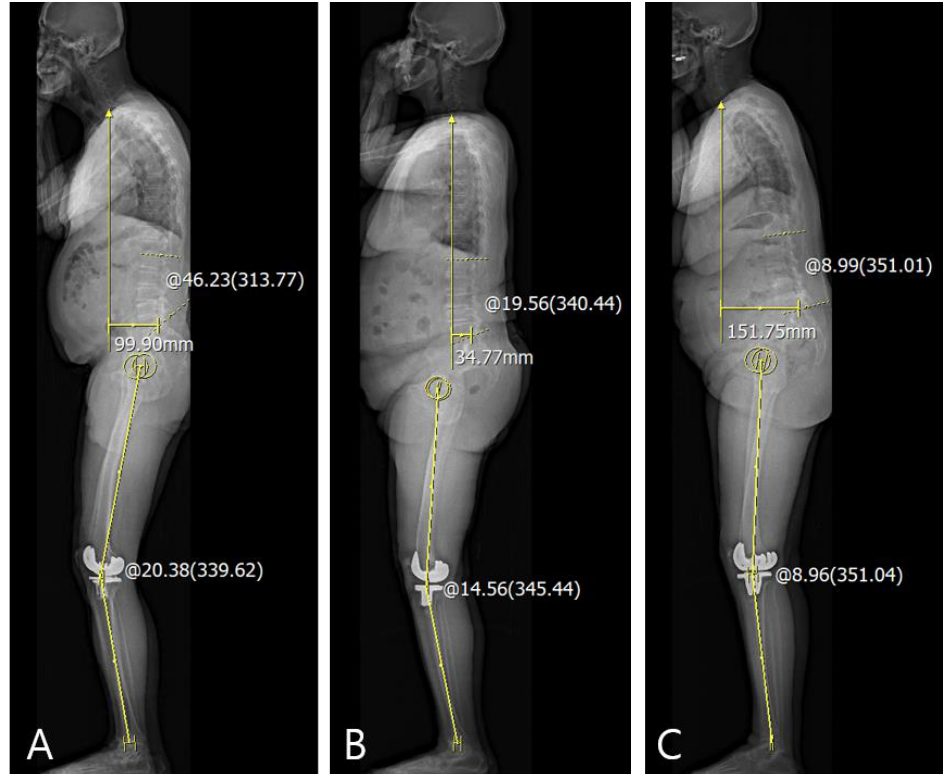
Figure 5. The difference between passive motion and weight-bearing of knee joint predominantly appeared if lumbar lordosis decreased or sagittal C7 plumb line was anteriorly located. ( A ) patient with anterior stooping because of anteriorly located C7 plumb line; ( B ) patient with decreased lumbar lordosis; ( C ) patient with combined anterior stooping and decreased lumbar lordosis.